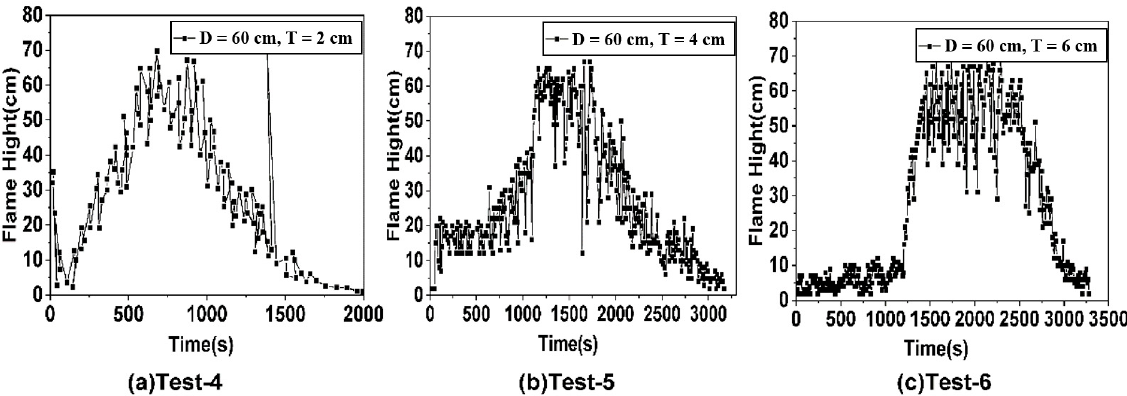
Figure 6. The flame height changes from Test-4 to Test-6 (where ( a ) is a coal pile of 60 cm diameter and 2 cm thickness, ( b ) is a coal pile of 60 cm diameter and 4 cm thickness, ( c ) is a coal pile of 60 cm diameter and 6 cm thickness).